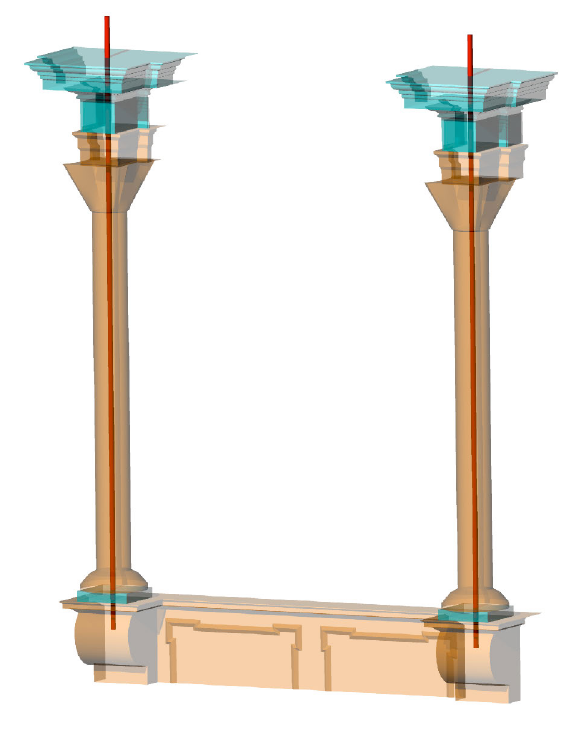
Figure 4: Column axes used as geometrical